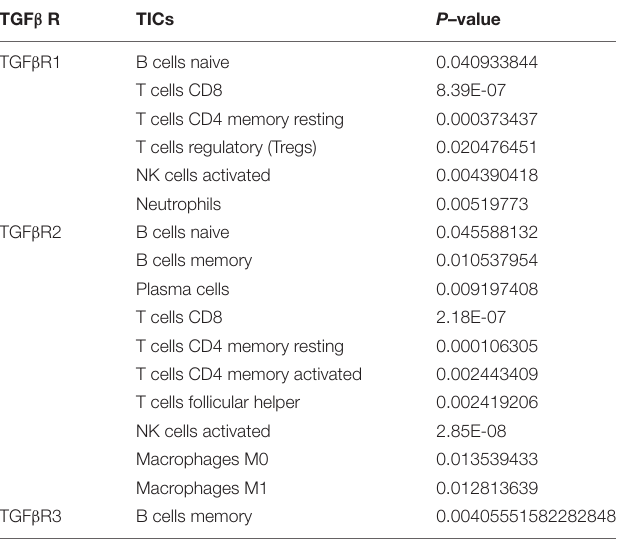
TABLE 1 | Correlation analysis between TGF β R and TICs in TIME of CC. TABLE 2 | Correlation analysis between SMAD and TICs in TIME of